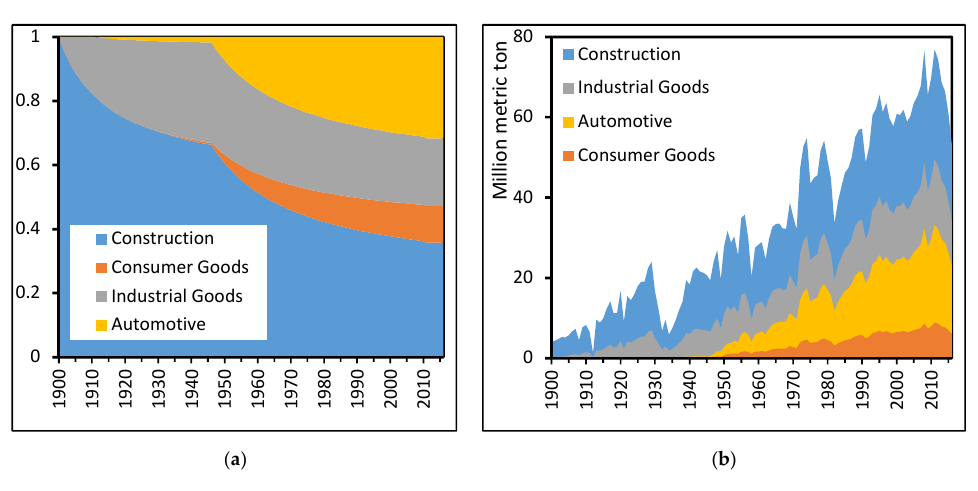
Figure 1. Input data on U.S. scrap collection by industry sector between 1900 and 2016: ( a ) ratios of scrap collected and ( b ) tonnages of scrap collection.